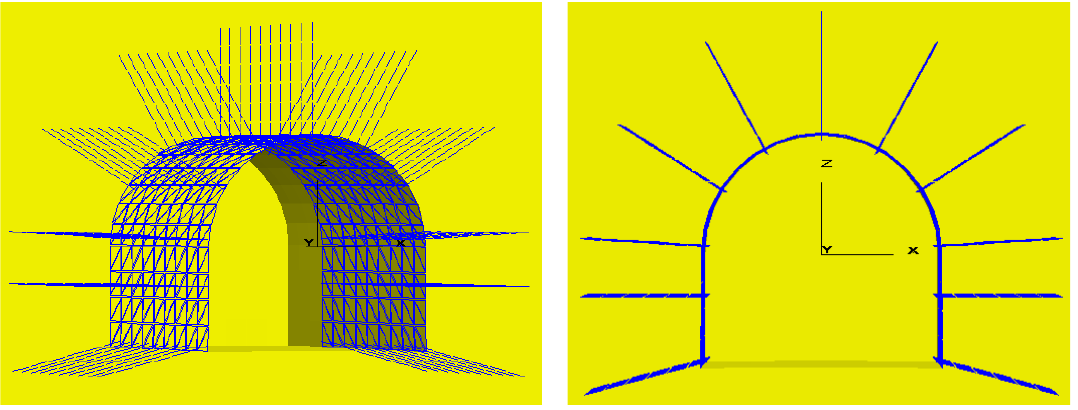
Figure 11. FLAC3D model of bolt-shotcrete net combined support.